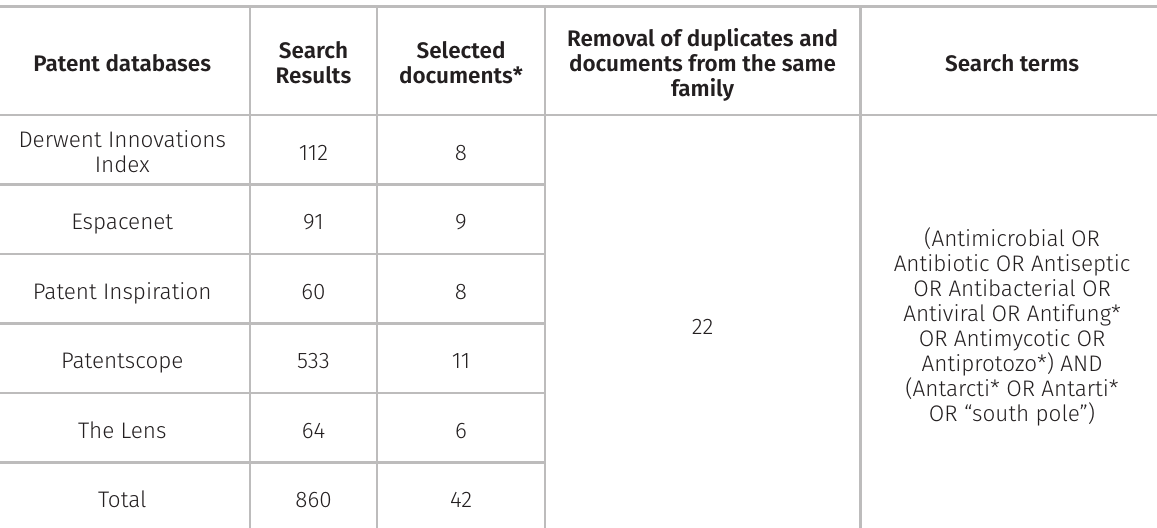
Table I. Patent search results. Patent databases